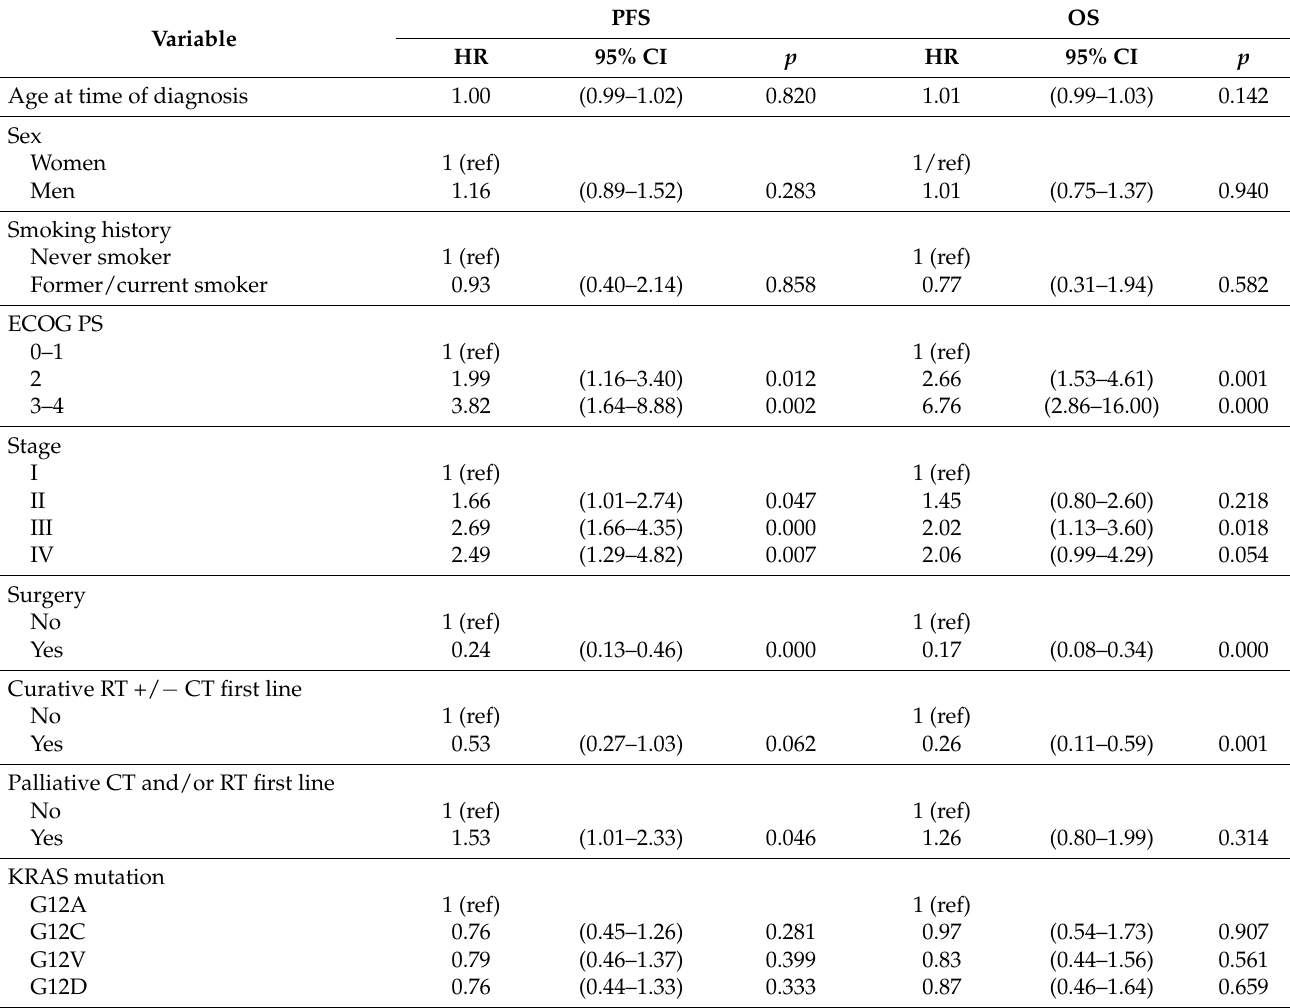
Figure 4. Progression free survival ( A ) and overall survival ( B ) in patients stage I–IV with KRAS G12C, G12V, G12D, and G12A mutated tumours. Table 4. Multivariable analyses of progression free survival and overall survival in patients stage I–IV with KRAS G12C, G12V, G12D, and G12A.